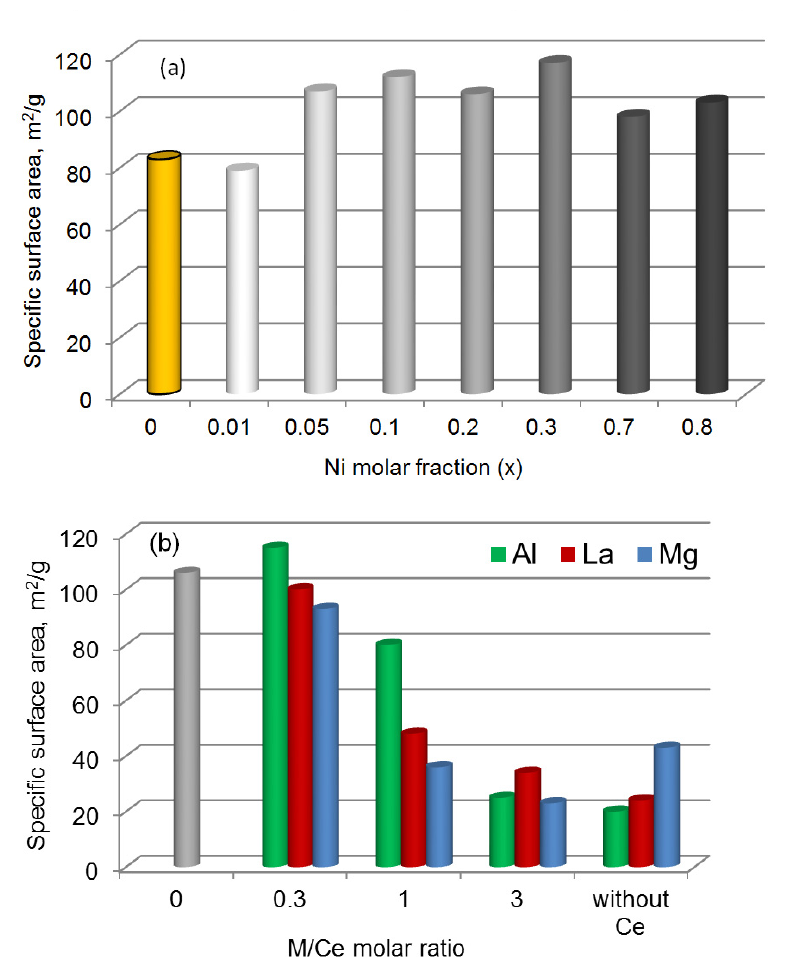
Figure 3. N 2 adsorption–desorption isotherms for (CeM) 1 − x Ni x O y (M = Al, La, Mg) samples: effect of Ni molar fraction ( a ) and M type ( b ). ( b )—M/Ce molar ratio is equal to 1. Isotherms are shifted relative to each other along the Y axis.